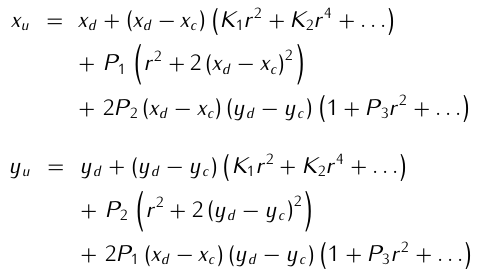
centered around each dot in the calibration grid. The calibration process constructs a mapping that can then be used to convert between pixel and real world units. This calibration information is applied to correct perspec- tive or nonlinear distortion errors for image display and shape/pattern